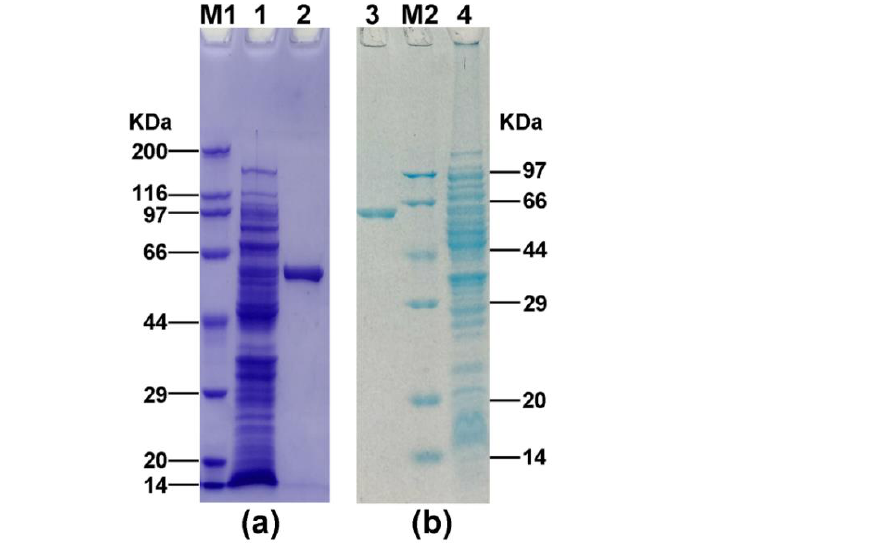
Figure 3. Effects of different temperatures ( a ) and pH ( b ) on the enzymatic activity of AlsS1 and Lineweaver – Burk plot of AlsS1 ( c ). The pH effect was measured in sodium acetate buffer (diamond), sodium phosphate buffer (circle), or glycine- sodium hydroxide buffer (uptriangle). Data were expressed as mean ± standard errors of three replicates.